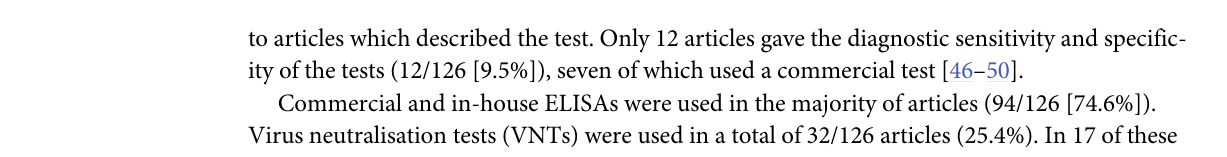
PLOS NeglectedTropical Diseases | https://doi.org/10.1371/journal.pntd.0006627 July 23,